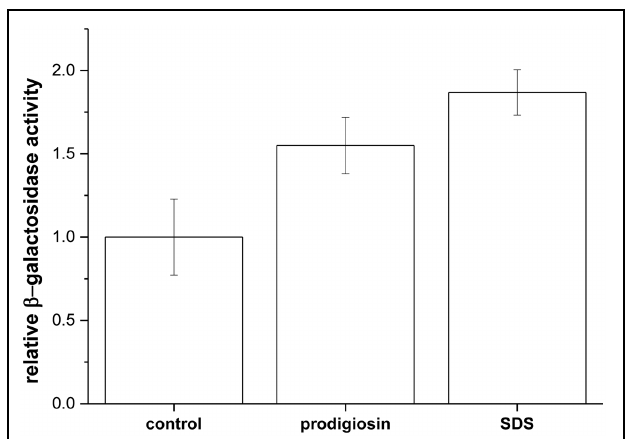
FIGURE 3 | Relative β -galactosidase activity upon addition of 5.9 mg L − 1 prodigiosin and 0.01% (w/V) SDS in B. subtilis PS-216 srfA-lacZ ( neo ) cells compared with control [addition of 0.19% (V/V) ethanol]. Cells were grown in LB medium at 37 ◦ C and 200 rpm. Data are presented as averages and standard errors ( n = 3–6).